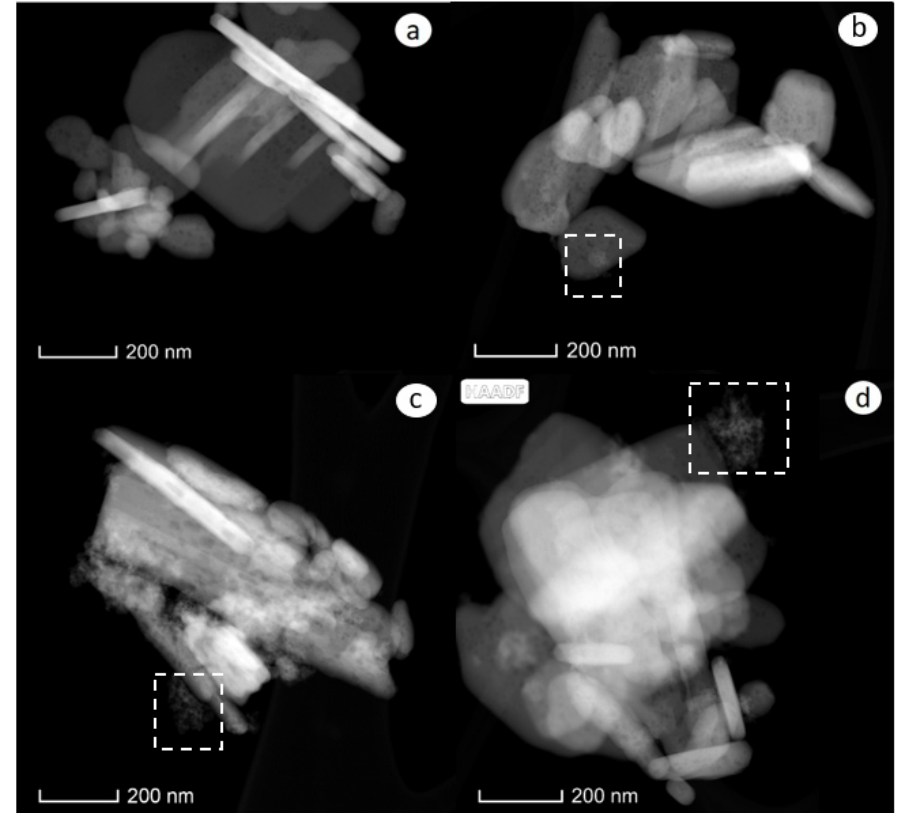
Figure 3. High-angle annular dark field-scanning transmission electron microscopy (HAADF-STEM) images of ( a ) ZnO, ( b ) ZnO:Ce 1%, ( c ) ZnO:Ce 2% and ( d ) ZnO:Ce 3%.